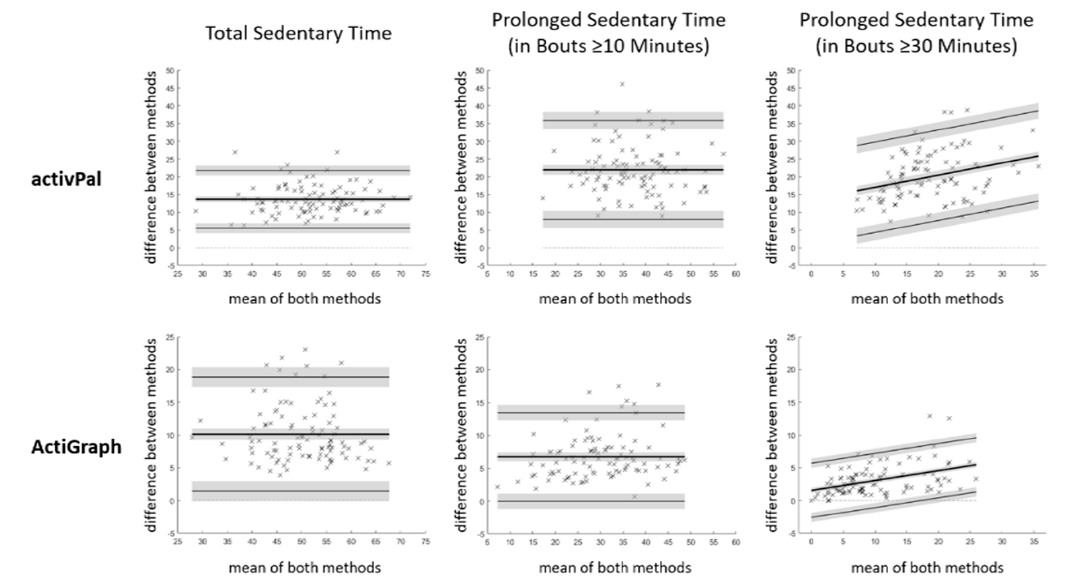
Figure 4. Bland-Altman plots for total and prolonged sedentary time. Data presented in % of waking hours (100% equals 15.0 h, n = 100). Indicated is the bias (bold line) and 95% limit of agreement (thin lines), both with 95% confidence interval (in grey). Note that the activPal y -axis ranges up to 50% and the ActiGraph y -axis up to 25% of waking hours.